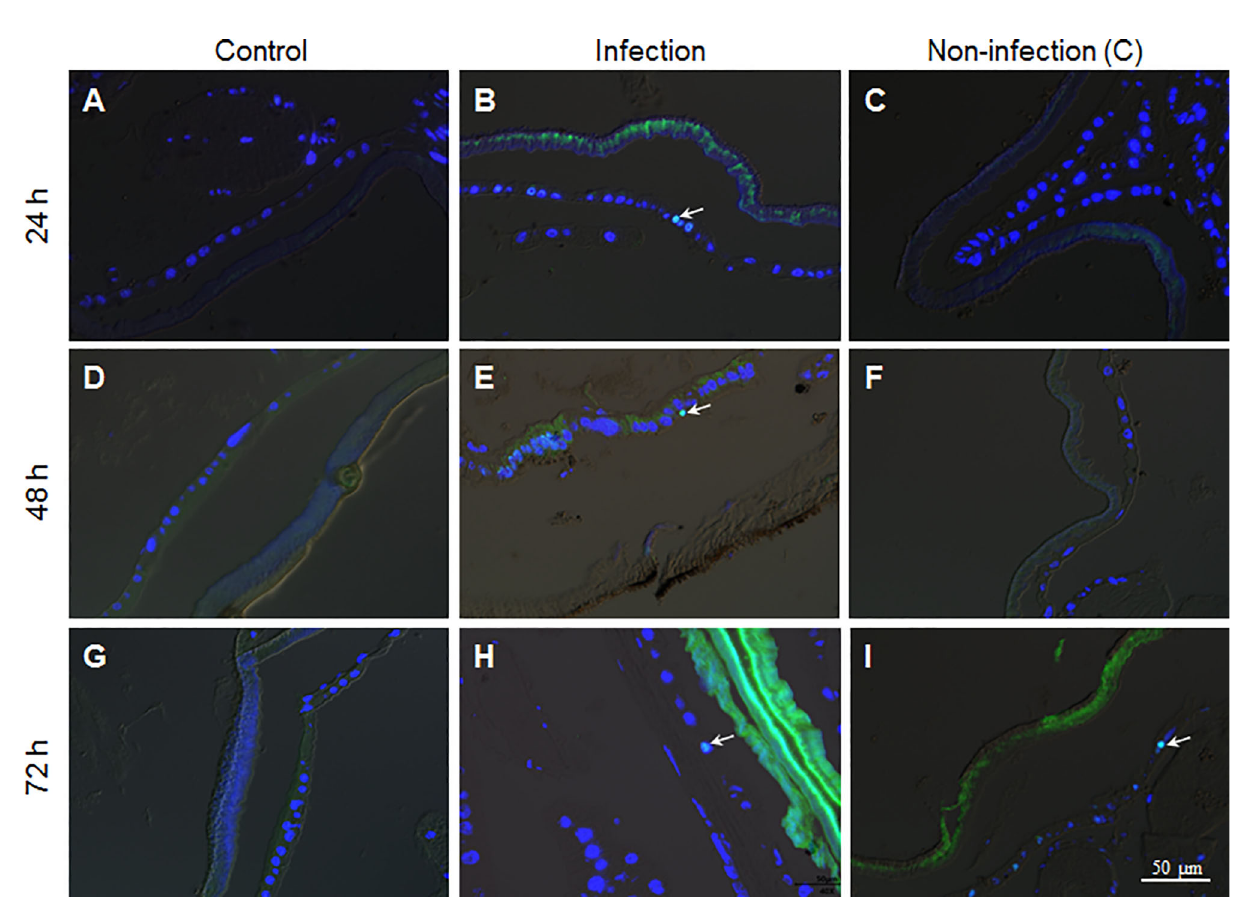
FIGURE 6 | The fi xed-site infection by B. bassiana promotes division in some epidermis cells. Samples were prepared as shown in Figure 5 and antibodies against the cell division marker PH3 were applied for immuno-staining. (A, D, G) No epidermal cell division was detected in the naive integument. (B, E, H) After the fi xed-site infection, some epidermis cells were PH3-positive (Green and arrow-point) at each time point assayed, indicating those epidermis cells undergoing division. (C, F, I) In the non-infection integuments, PH3-positive cells were also detected, particularly at 72 h after infection (arrow-point). Nuclei were counter-stained by